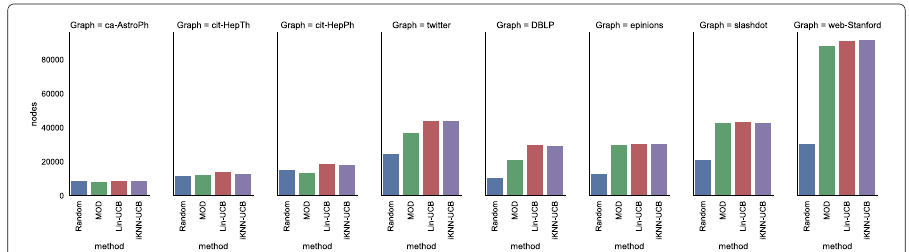
Fig. 7 Comparison against baselines: 1000 probes run on 5% nodes of each network. Each sample is created by performing a random walk on the original network